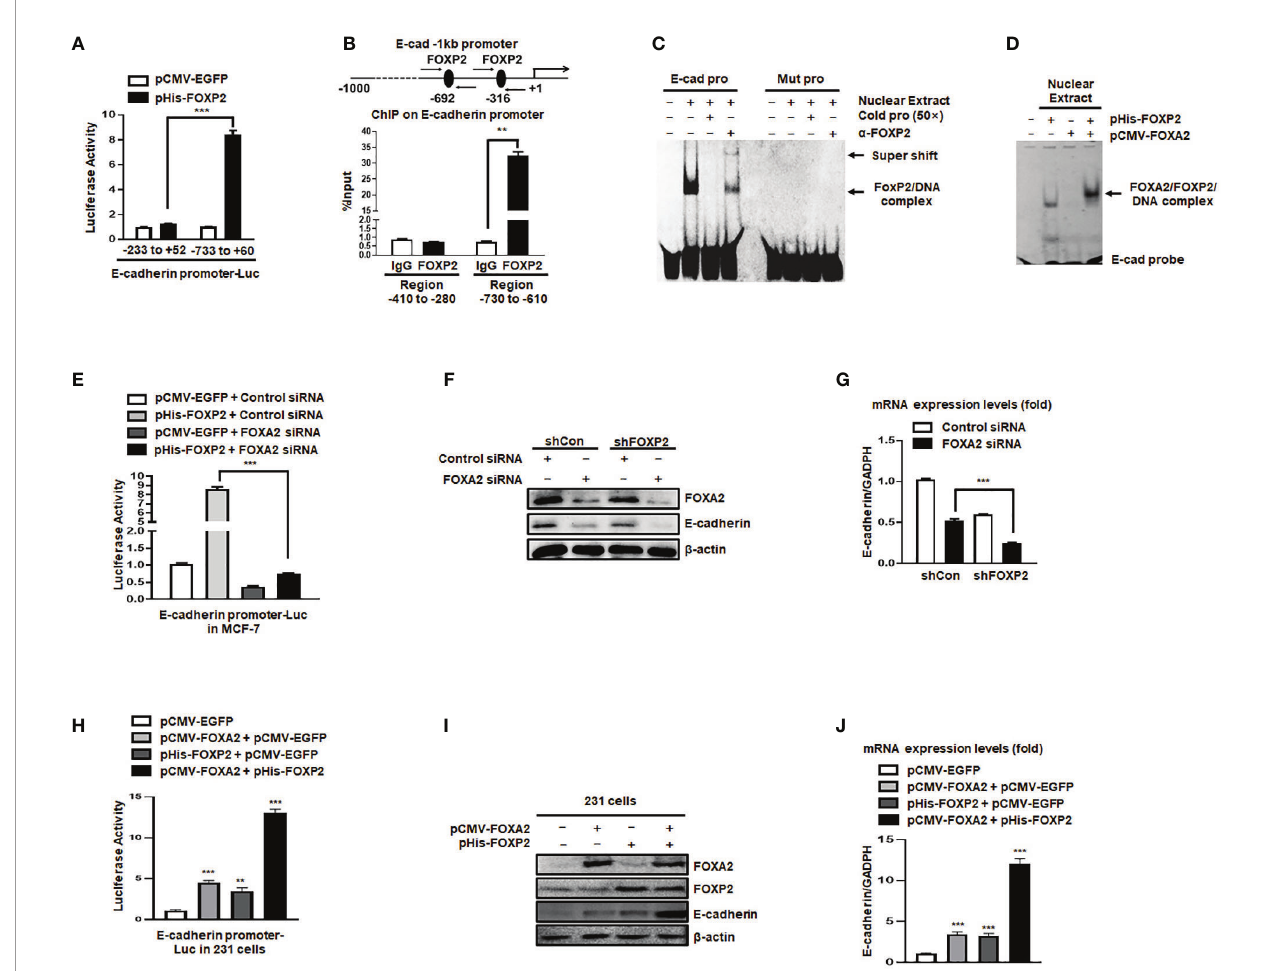
FIGURE 4 | The activation of the E-cadherin promoter by FOXP2 relied on the participation of FOXA2. (A) The E-cadherin promoter was activated by FOXP2 in breast cancer cells. A luciferase reporter plasmid (1.5 m g) containing the fragment of -733bp to +60 bp of E-cadherin promoter or a control luciferase reporter plasmid (1.5 m g) containing the fragment of -233 bp to +52 bp of E-cadherin promoter and loading control pRL-CMV luciferase reporter plasmid (20 ng) were transfected into MCF-7 cells with pHis-FOXP2 or pCMV-EGFP (1 m g). (B) FOXP2 bound to the endogenous E-cadherin promoter. Gene sequence analysis was performed to predict positions of putative FOXP2 binding sites in -1 kb human E-cadherin promoter and the primers for ChIP assays were designed. The chromatin of MCF-7 cells was cross-linked, sonicated, and immunoprecipitated (IP) with either FOXP2 antibody or rabbit IgG. The amount of promoter DNA associated with the IP chromatin was measured by qPCR with primers speci fi c to E-cadherin promoter regions -760 bp to -610 bp and -414 bp to -280 bp. (C) FOXP2 bound to E- cadherin promoter region -701 bp to -691 bp. Nuclear extracts were prepared from pHis-FOXP2-transfected cells and used for EMSAs with a FAM-labeled DNA probe synthesized from E-cadherin promoter sequence -706 bp to − 686 bp (E-cad pro). The unlabeled probe (50×) or 1 m g of FOXP2 antibody ( a -FOXP2) was added to the reaction to show the speci fi city of FOXP2/DNA complex formation. EMSAs with a FAM-labeled mutated probe were also performed (Mut pro). (D) FOXP2 mediated the binding of FOXA2 to the E-cadherin promoter. Nuclear extracts were prepared from pHis-FOXP2-transfected, pCMV-FOXA2-transfected, or both-transfected cells (48 h) and used for EMSAs with a FAM-labeled DNA probe synthesized from E-cadherin promoter sequence -706 bp to -686 (E-cad probe). (E) Knockdown of FOXA2 abolished the activation of the E-cadherin promoter by FOXP2. A luciferase reporter plasmid (1.5 m g) containing the fragment of -733 bp to +60 bp of E-cadherin promoter and loading control pRL-CMV luciferase reporter plasmid (20 ng) were transfected into MCF-7 cells with the pHis-FOXP2 or pCMV-EGFP (1 m g) plus FOXA2 siRNA or Control siRNA (200 nM). Protein lysates were prepared at 36 h following transfection and used to measure dual luciferase enzyme activities. (F, G) The knockdown of FOXP2 and FOXA2 together showed a synergistic repression of the E-cadherin expression in breast cancer cells. The shCon MCF-7 cells and shFOXP2 MCF-7 cells were transfected with Control siRNA or FOXA2 siRNA (200 nM) and examined by qPCR for mRNA levels (F) and by Western blotting for protein levels (G) . (H) Overexpression of FOXA2 enhanced the activation of the E-cadherin promoter by FOXP2 in MDA-MB-231 cells. A luciferase reporter plasmid (1.5 m g) containing the fragment of -733 bp to +60 bp of E-cadherin promoter and loading control pRL-CMV luciferase reporter plasmid (20 ng) were transfected into MDA-MB-231 cells with the pCMV-FOXA2 (1 m g), pHis-FOXP2 (1 m g), or both (balanced with the pCMV-EGFP vector). Protein lysates were prepared at 36 h following transfection and used to measure dual luciferase enzyme activities. (I, J) The overexpression of FOXP2 and FOXA2 together showed a synergistic activation of the E-cadherin expression in MDA-MB-231 cells. The MDA-MB-231 cells were transfected with FOXA2 expression vector (pCMV-FOXA2), FOXP2 expression vector (pHis-FOXP2), or both (balanced with the pCMV-EGFP vector) and examined by Western blotting for protein levels (I) and by qPCR for mRNA levels (J) . The asterisks indicate statistically signi fi cant changes: **P ≤ 0.01, ***P ≤